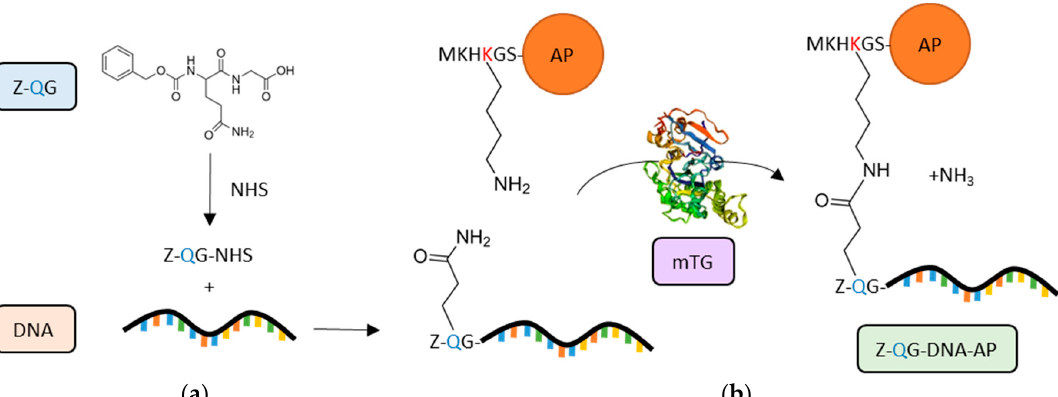
Figure 5. Protein-DNA conjugation. By exploiting benzyloxycarbonyl- L -glutaminylglycine (Z-QG) as a TG substrate, mTG induces site-specific and covalent conjugation of DNA to proteins, such as alkaline phosphatase (AP). ( a ) Chemical activation of Z-QG carboxylate with N-hydroxysuccinimide (NHS) and formation of the activated Z-QG-NHS, which is then modified by addition of an aminated oligodeoxynucleotide (DNA). ( b ) mTG mediates the formation of a crosslink between the Gln residue of Z-QG-DNA and the Lys residue of the MKHKGS peptide tag fused to AP. The Q and K side chains are superimposed to visualize the TG reaction [213]. The modelling software, “EzMol”, was used to generate mTG structure (PDB: 1IU4) [34].